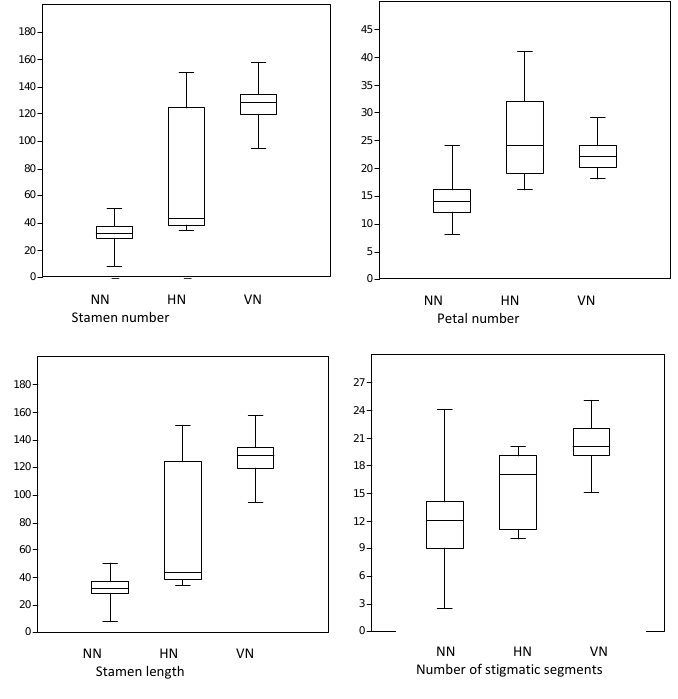
Figure 5: Box-and-whisker plots illustrating the most contributed characters for the separation, where most of them exhibit an overlapping nature in the hybrids. N. nouchali (NN), violet flowered Nymphaea (VN) and tentative hybrid